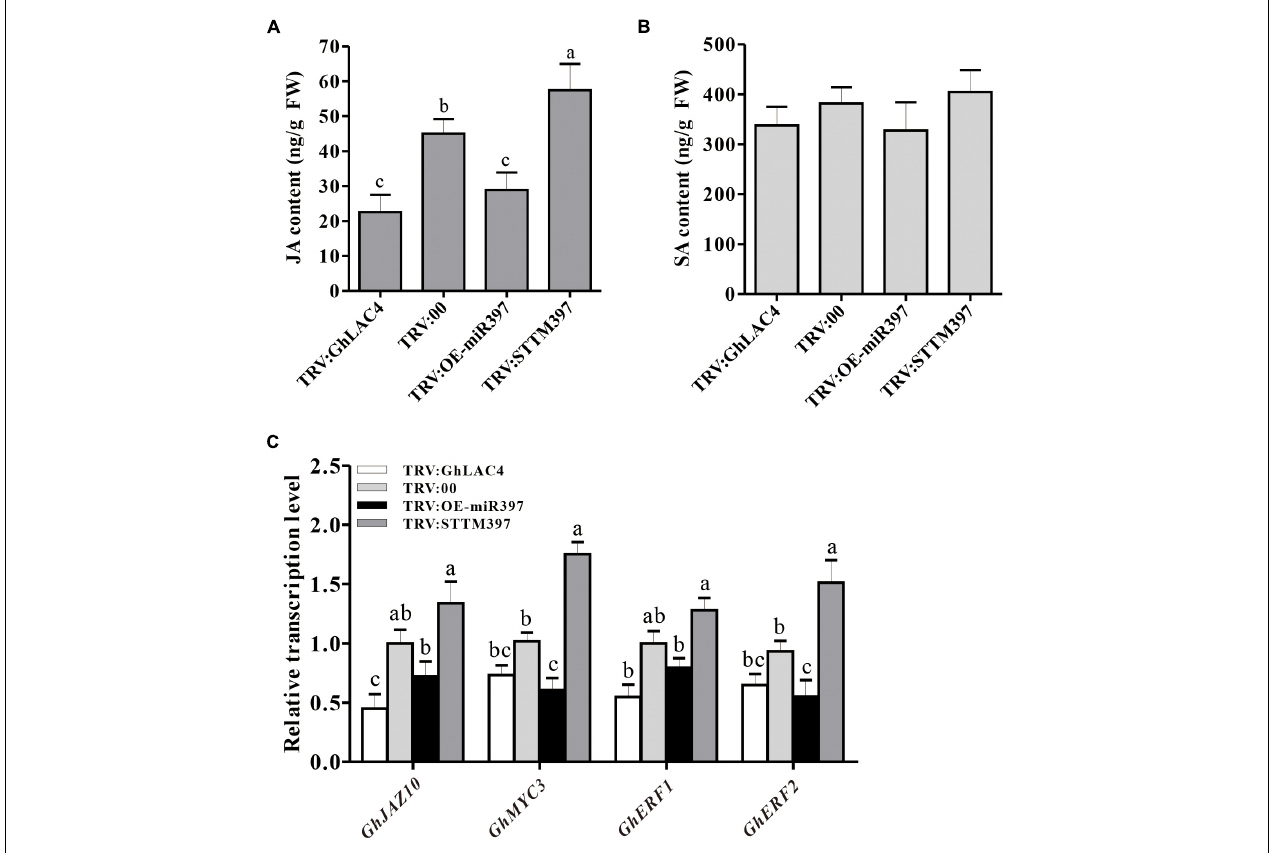
FIGURE 5 | Measurement of JA and SA content in the plants inoculated with V. dahliae . (A) JA contents in TRV:STTM397, TRV:OE-miR397, TRV:GhLAC4, and the control plants inoculated with V. dahliae . (B) SA contents in TRV:STTM397, TRV:OE-miR397, TRV:GhLAC4, and the control plants inoculated with V. dahliae . (C) Expression analysis of JA signalling pathway-related genes with V. dahliae . GhUBQ7 was an internal reference gene. Mean with SD comes from triple repeats experiments. Different letters in (A–C) indicate significant difference ( P < 0.05) based on Tukey’s HSD